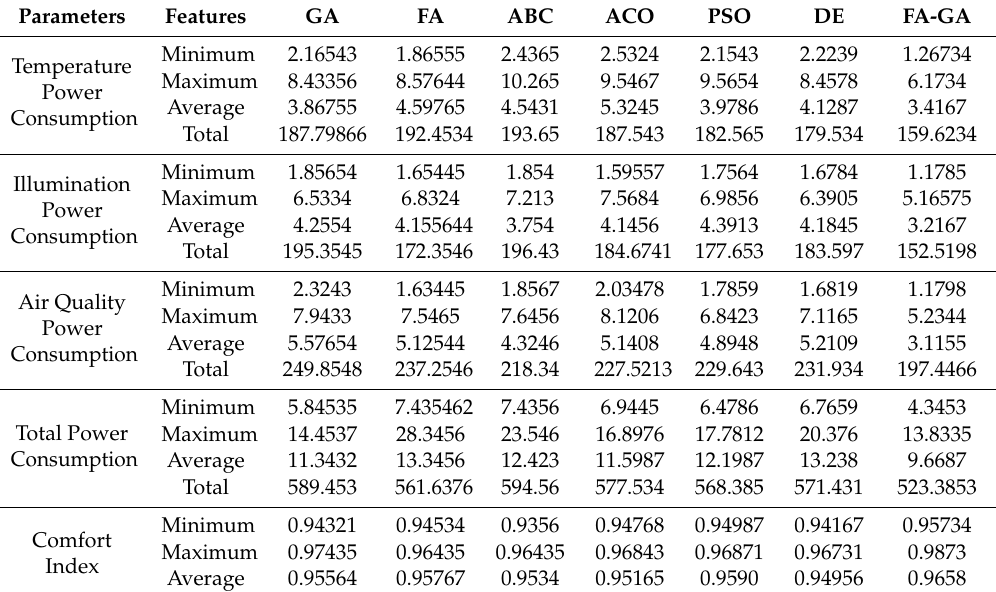
Table 7. Statistical analysis based on all the considered